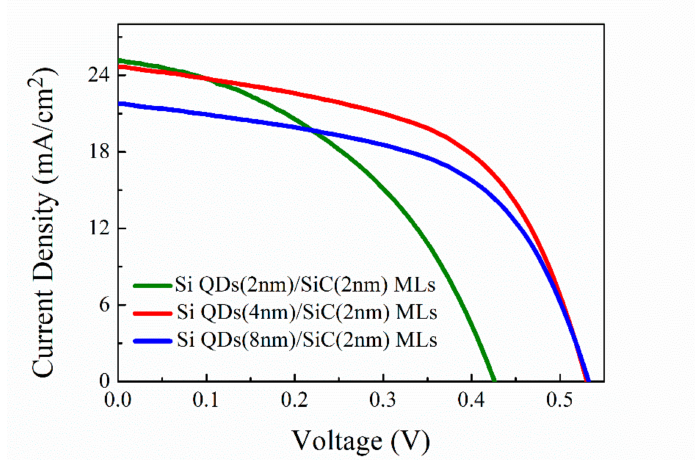
Figure 4. Dark I-V curves of di ff erent-sized Si QDs / SiC MLs-based solar cells.